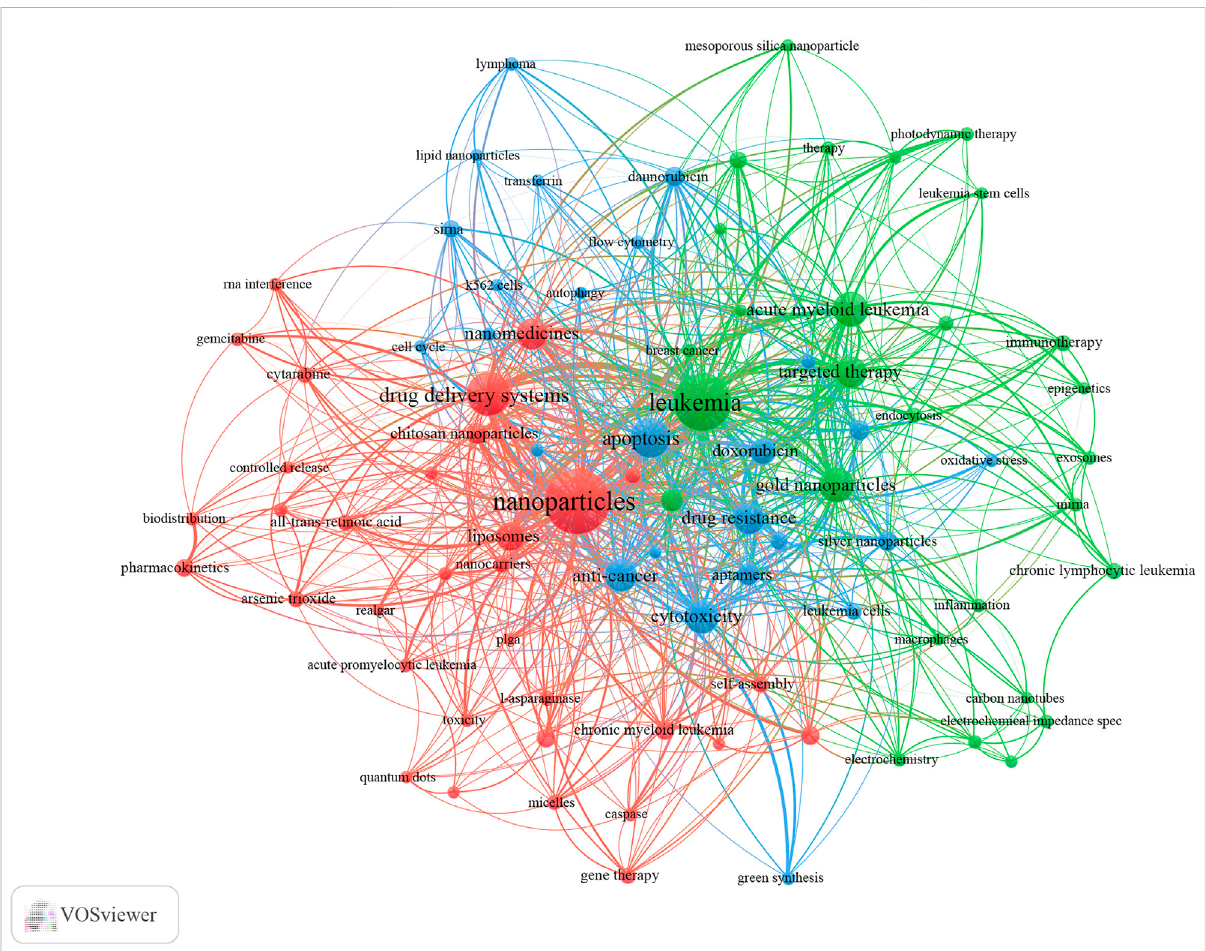
FIGURE 7 Keyword co-occurrence network and clusters in Nanoparticles-leukemia research (Notes: The size of the node and word re fl ects the co- occurrence frequencies, the link indicates the co-occurrence relationship, and the same color of the node represents the same cluster.